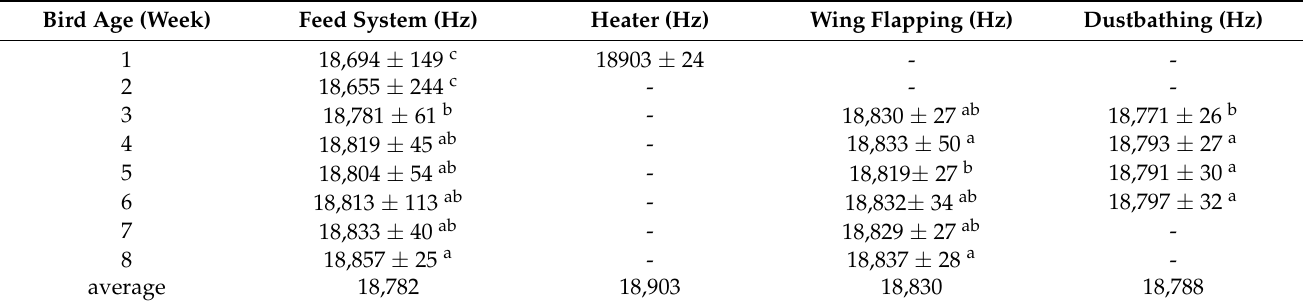
Table 4. Upper frequency limits of feed system, heater, wing flapping and dustbathing at different bird ages (mean ± SD). Bird Age (Week) Feed System (Hz) Heater (Hz) Wing Flapping (Hz)